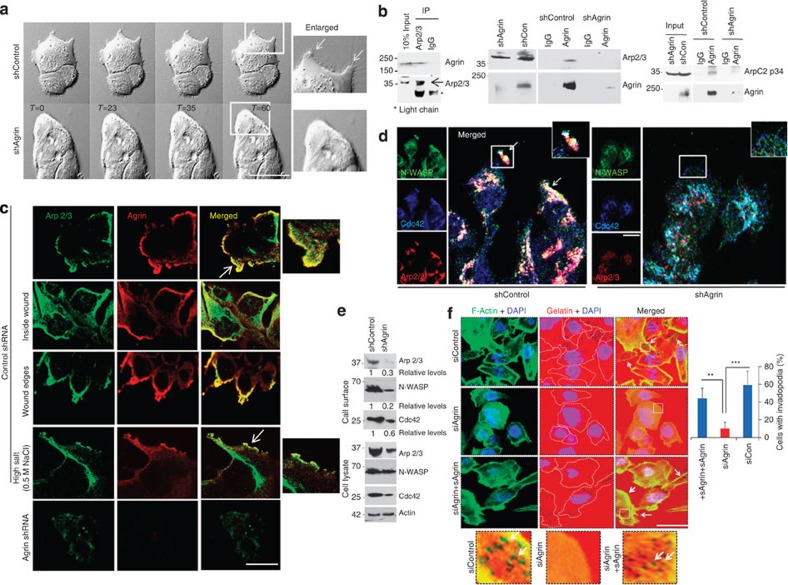
Agrin regulates ruffling and invadopodia in HCC cell lines.(a) Representative live-cell time-lapse differential interference contrast images of control and Agrin knockdown cells at indicated time frames (in seconds) are shown. Scale bar, 10 μm. Boxed area is represented as enlarged panels. Arrows indicate membrane ruffles/protrusions. (b) MHCC-LM3 cells IP using Arp2/3 subunit 1B (left panel) or Agrin antibodies (middle and rightmost panels) and IgG were analysed by western blotting for Agrin, Arp2/3 subunits 1B or ArpC2p34. The blot was stripped and re-probed for Arp2/3 or Agrin. Thirty micrograms (10%) of whole-cell lysate were used as input control. Lysates from Agrin knockdown cells (right panel) were used as negative control. (c) Immunofluorescence analysis of control and Agrin knockdown MHCC-LM3 cells 12 h post scratch assay using goat Arp2/3 antibody and mouse Agrin antibody. Representative confocal images are shown. Panels (ii and iii) represent images of cells within the wound area and edges of wound, respectively. For panel (iv), cells were washed two times with high salt wash buffer (0.5 M NaCl) for 10 min at RT before fixation and immunostaining. Enlarged Z sections were performed at the leading edge of membrane ruffles marked by white arrows. Scale bar, 10 μm. (d) Cells were processed similarly as in c and immunostained with mouse anti-WASP, rabbit anti-Cdc42 and goat anti-Arp2/3. Boxed area is represented as enlarged panel inset. Scale bar, 10 μm. (e) Biotinylated surface proteins from control or Agrin knockdown MHCC-LM3 cells were analysed by a western blot for indicated proteins. Total cell lysate was also western blotted and β-actin served as a loading control. (f) Control and Agrin siRNA-transfected cells either untreated or treated with soluble Agrin (20 μg ml−1) for 12 h were cultured on Cy3-Gelatin for another 12 h, fixed and then stained with F-actin and DAPI. Representative confocal images are shown and invadopodia was quantified using ImageJ. Boxed areas are represented as enlarged lower panels. Arrows indicate F-actin-enriched degraded gelatin areas. Scale bar, 10 μm. At least five different fields were quantified and error bars indicate the s.d. of means of at least three independent experiments (***P value=0.0005, **P value=0.004, respectively, Student’s t test).